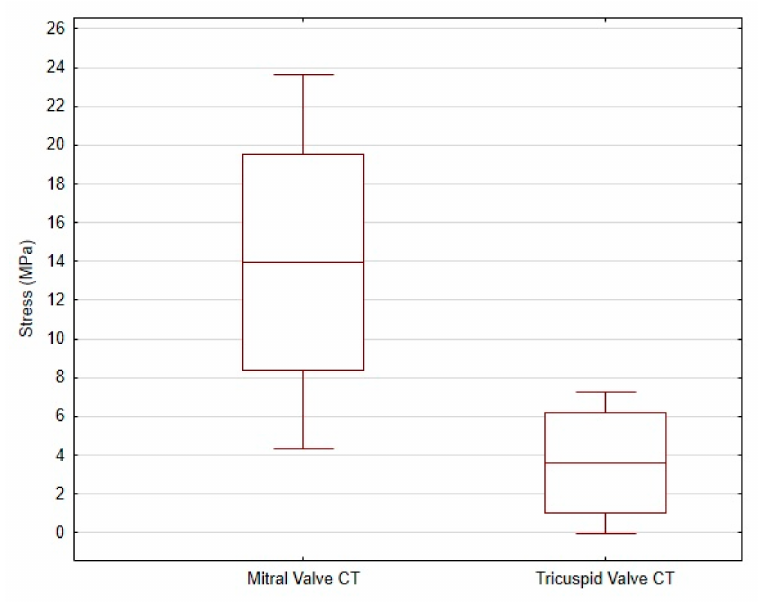
Figure 4. The mean and standard deviation of the stress values in the mitral valve CT and the tricuspid valve CT of dogs.